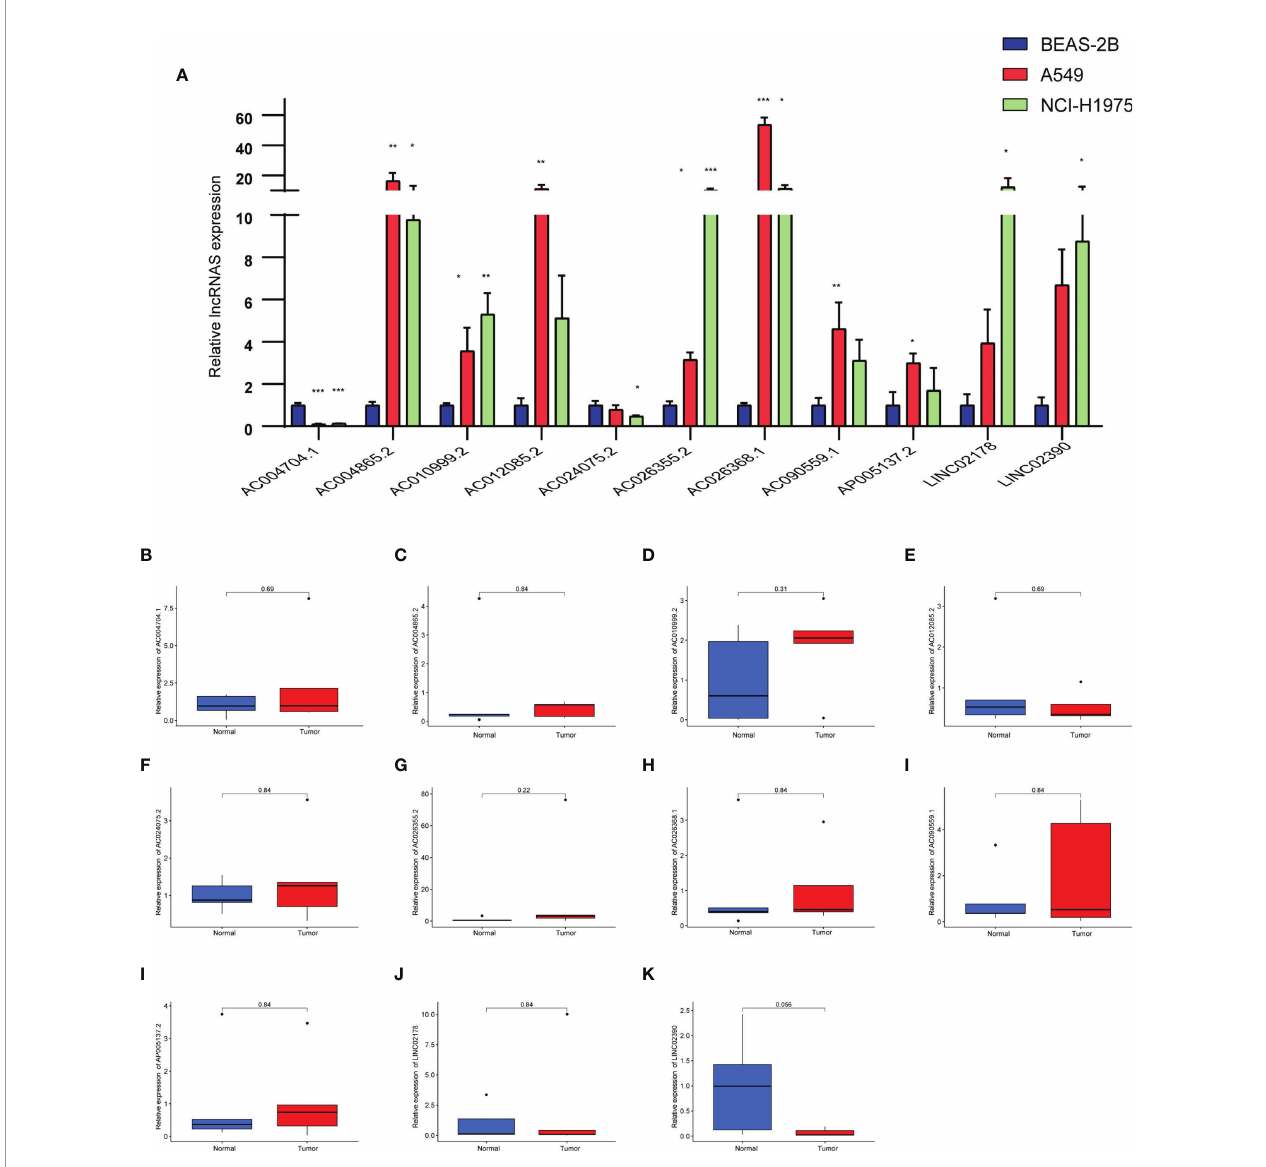
FIGURE 10 | (A) Expression levels of 11 pyroptosis-related lncRNAs in the normal lung epithelial cell line BEAS-2B and two LUAD cell lines (A549, NCI-H1975) by RT-qPCR. (B – K) Expression levels of 11 pyroptosis-related lncRNAs in LUAD tissues and corresponding normal tissues by RT-qPCR. Data represent the mean ± SD. *P < 0.05, **P < 0.01, ***P < 0.001. P values were determined by one-way